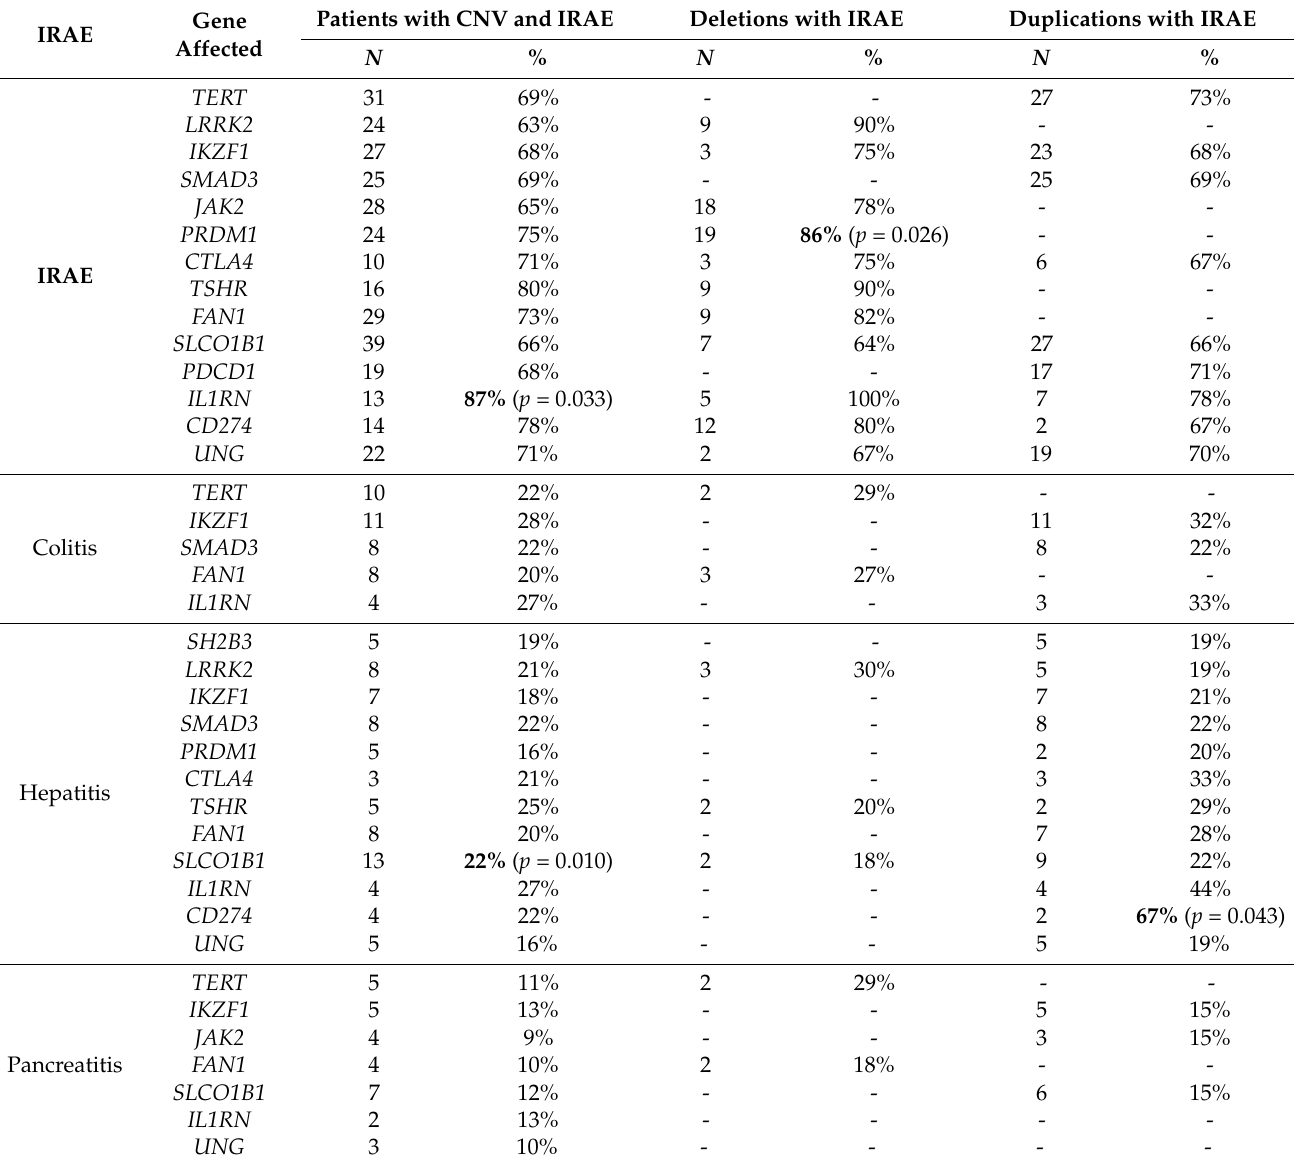
Table 7. Genes affected by CNVs (deletions or duplications) in relation to observed IRAE. Note that we only list genes with observed incidence of IRAE above the respective cohort average and concerning at least two